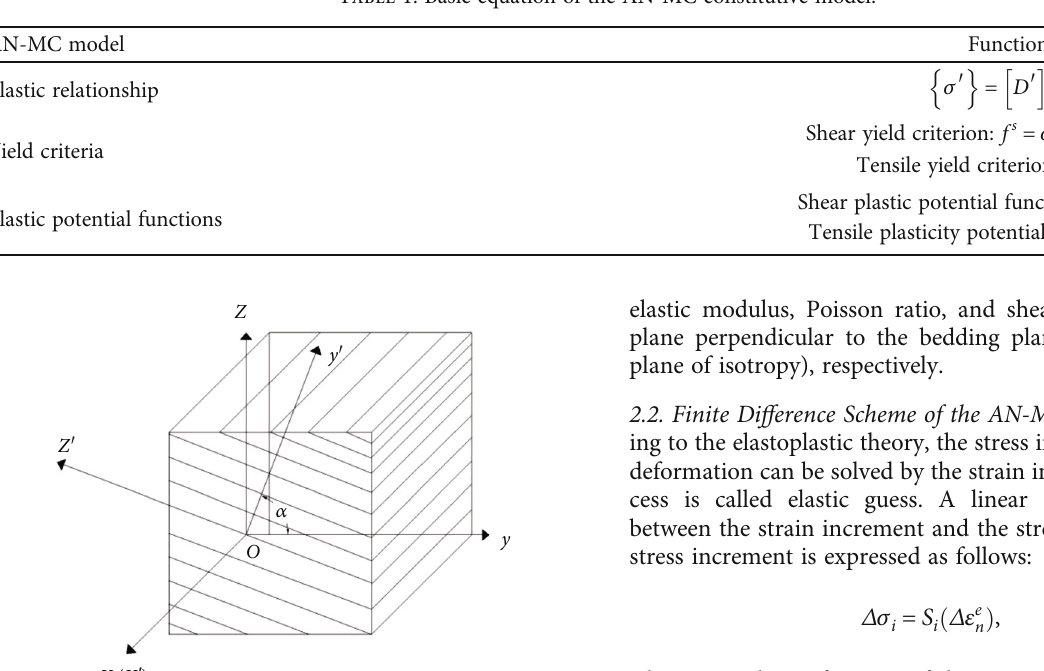
Table 1: Basic equation of the AN-MC constitutive model.